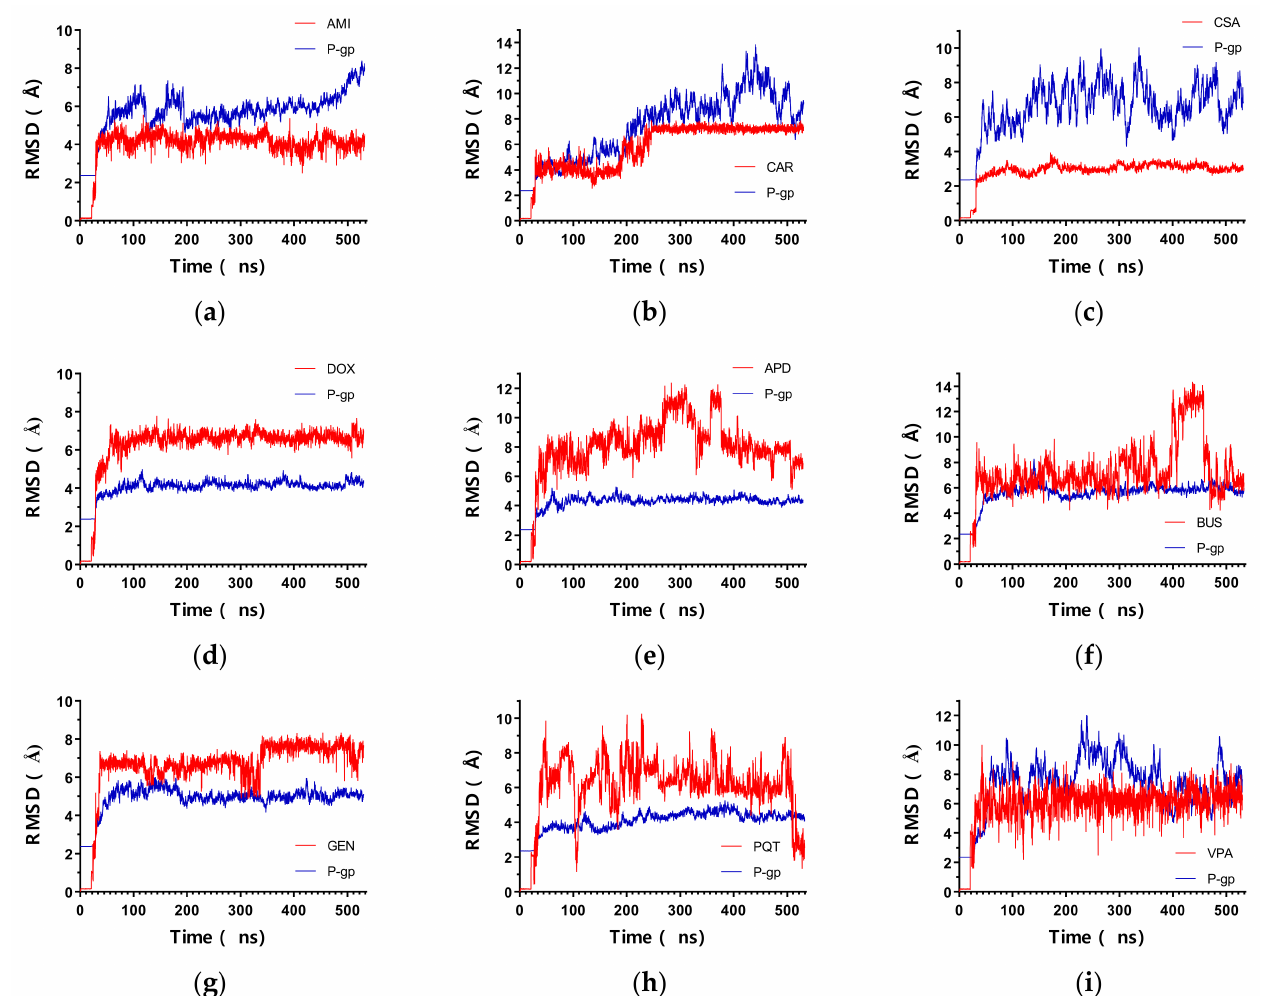
Figure 2. RMSD vs time of the simulated P-gp–ligand complexes: backbone atoms of the pro- tein chains (blue) and ligand (red). ( a ) P-gp–AMI; ( b ) P-gp–CAR; ( c ) P-gp–CSA; ( d ) P-gp–DOX; ( e ) P-gp–APD; ( f ) P-gp–BUS; ( g ) P-gp–GEN; ( h ) P-gp–PQT; ( i )